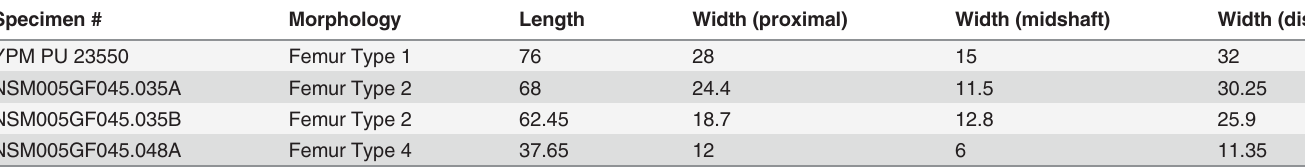
Table 2. Principle measurements (in mm) of select femora from Blue Beach. Specimen # Morphology Length Width